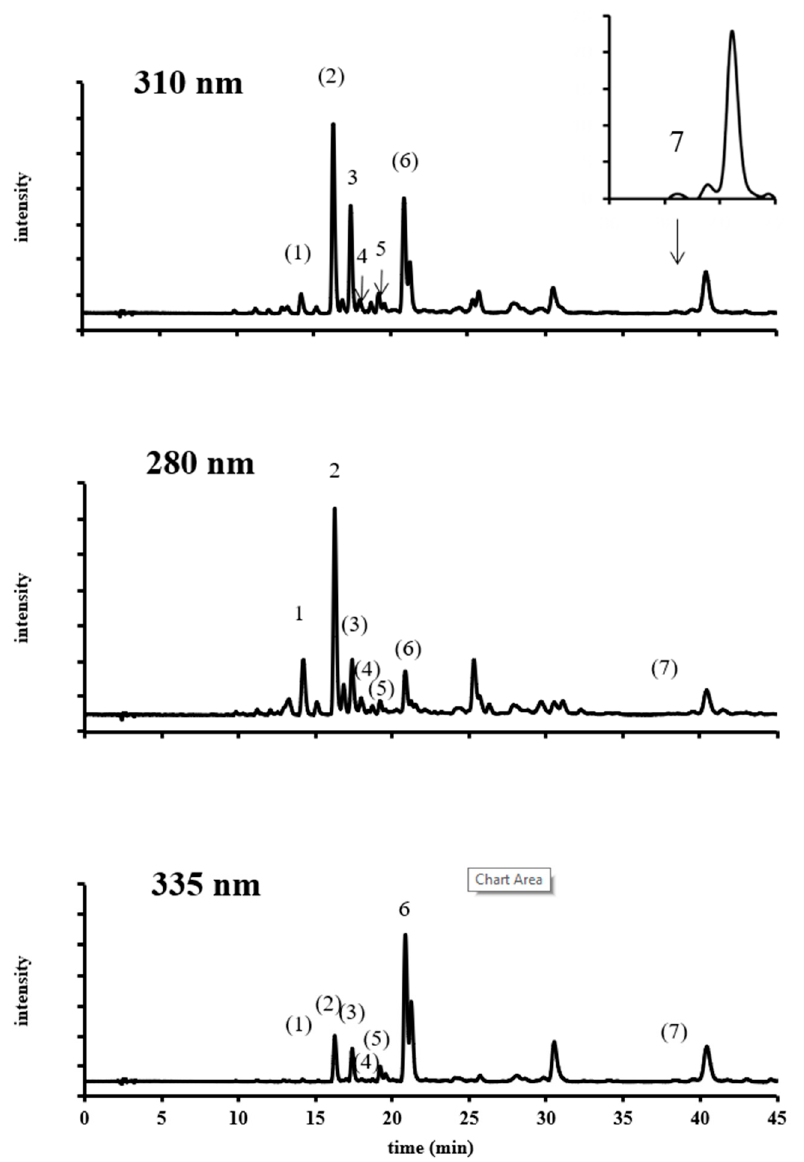
Figure 2. Chromatogram of a cactus seed oil sample. (1) 4-hydroxy benzaldehyde; (2) vanillin; (3) syringaldehyde; (4) p -coumaric acid; (5) ferulic acid; (6) ferulaldehyde; (7) p -coumaric acid ethyl ester. Compounds with numbers within brackets were quantified with another wavelength.